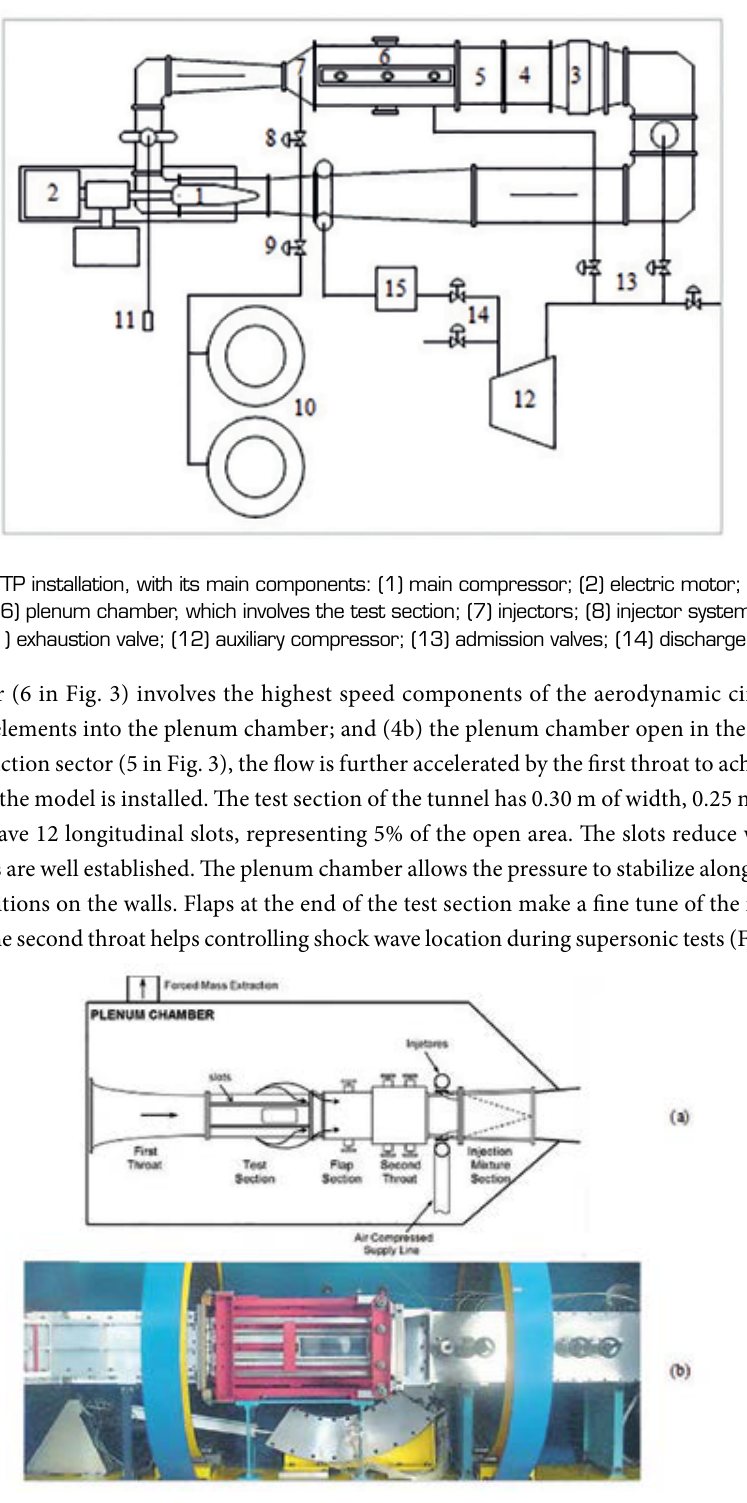
Figure 4. Diagram with internal parts of the plenum chamber (a); and the internal view